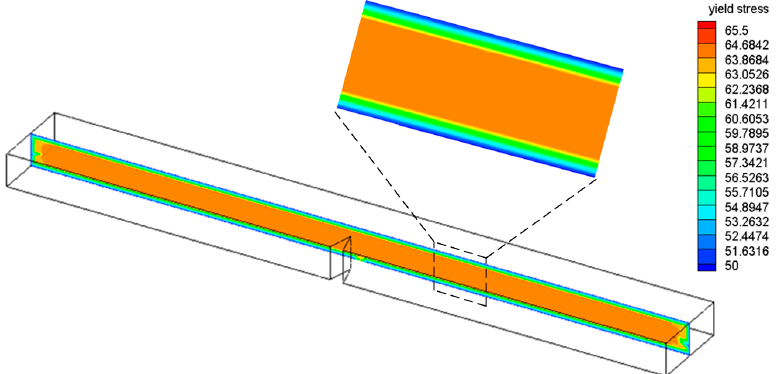
Figure 5. Distributions of yield stress within the center cross-section.